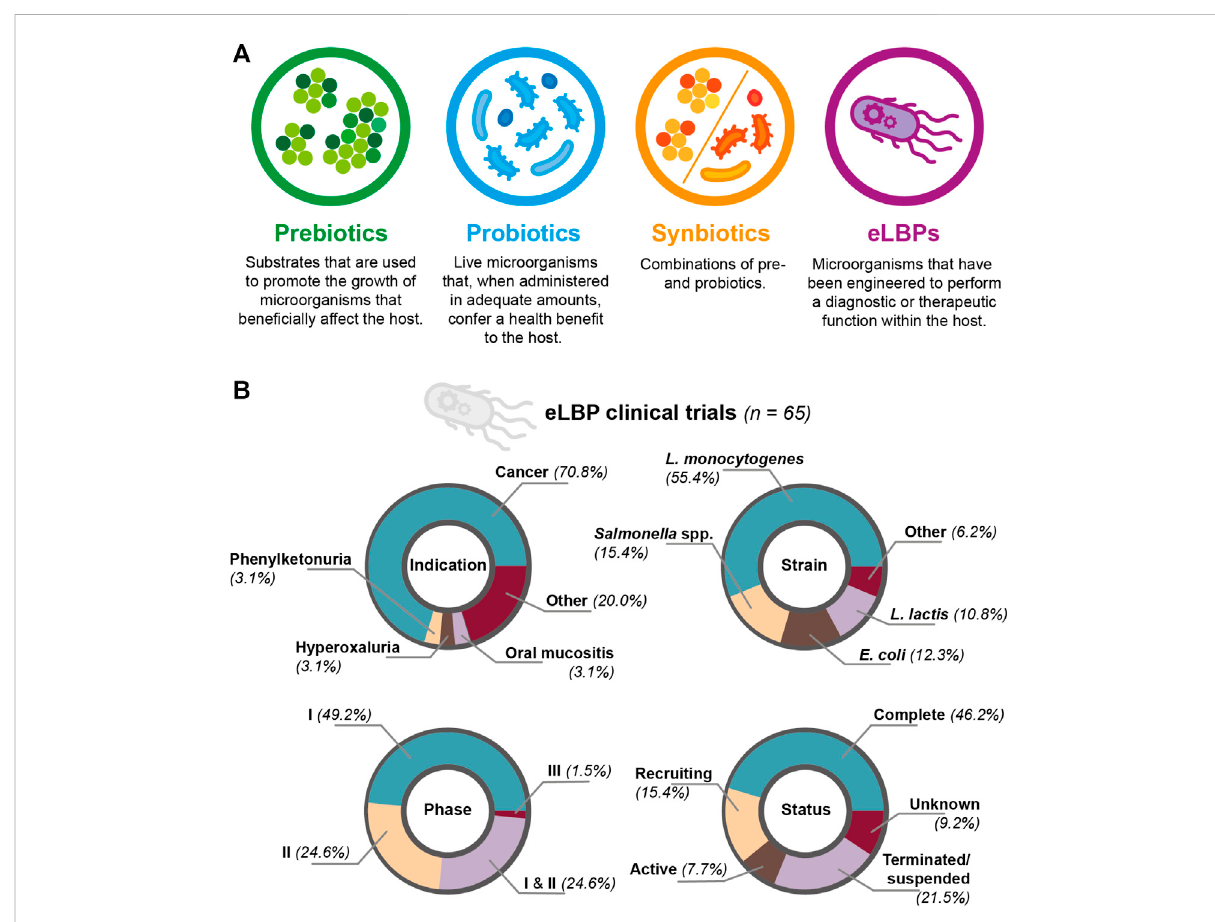
FIGURE 2 (A) Comparison of prebiotics, probiotics, synbiotics and eLBPs. All offer promising routes for modifying the human microbiotia (B) Summary of clinical trials involving eLBPs (genetically-modi fi ed microorganisms used for a therapeutic purpose), discovered during this literature